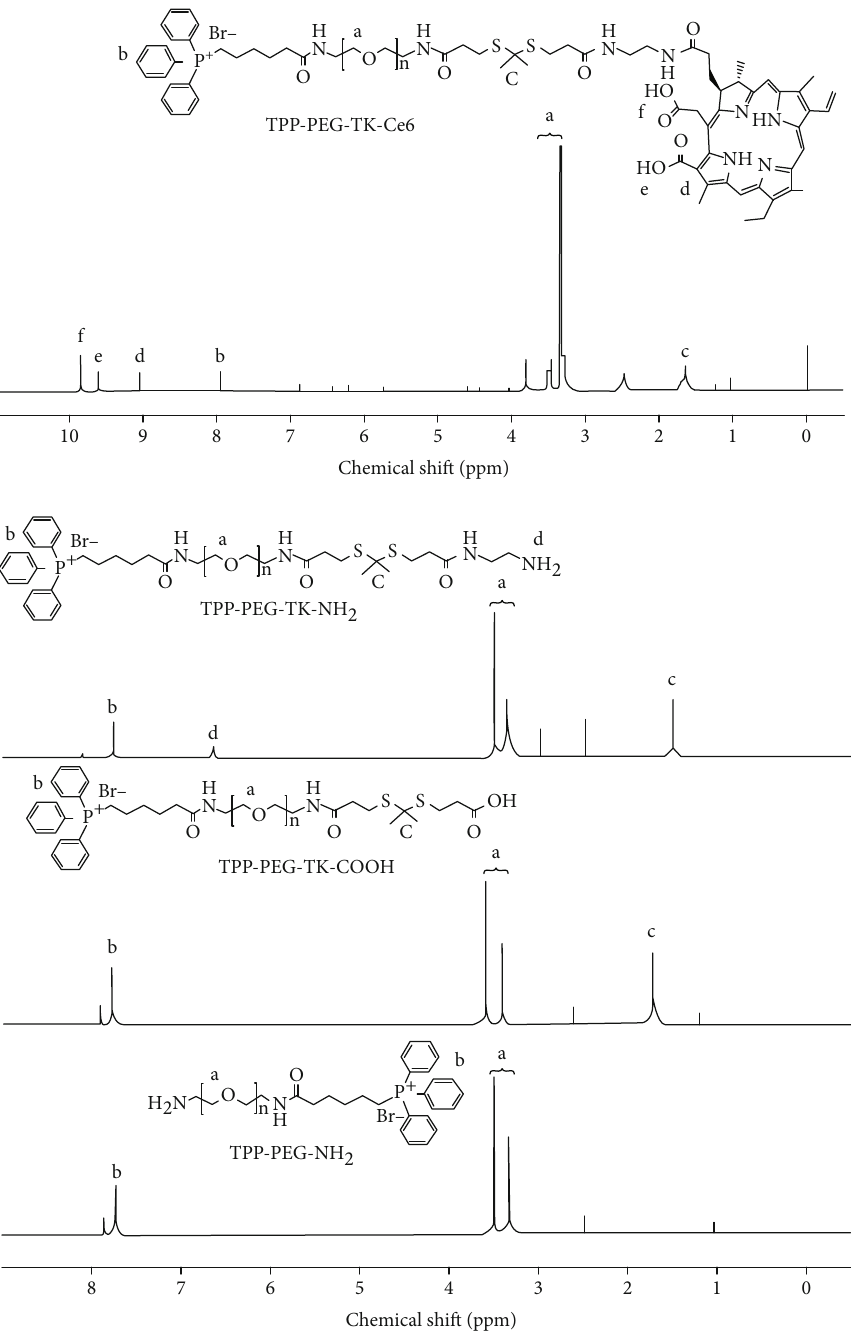
Figure 2: 1 H NMR spectra of TPP-PEG-NH